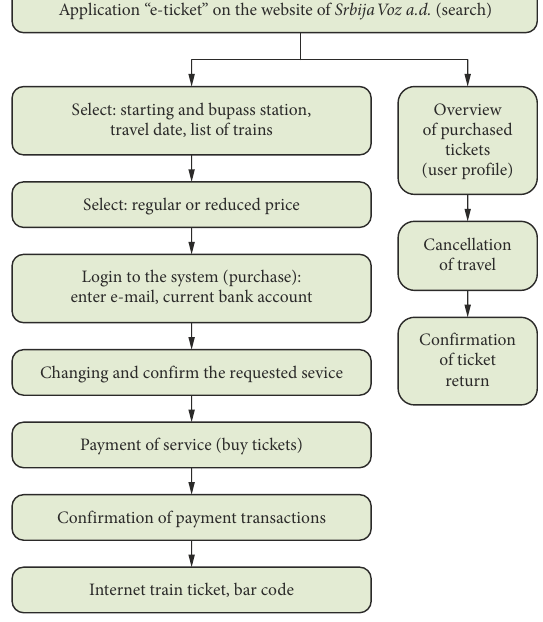
Figure 2. Review of necessary steps in the scalable